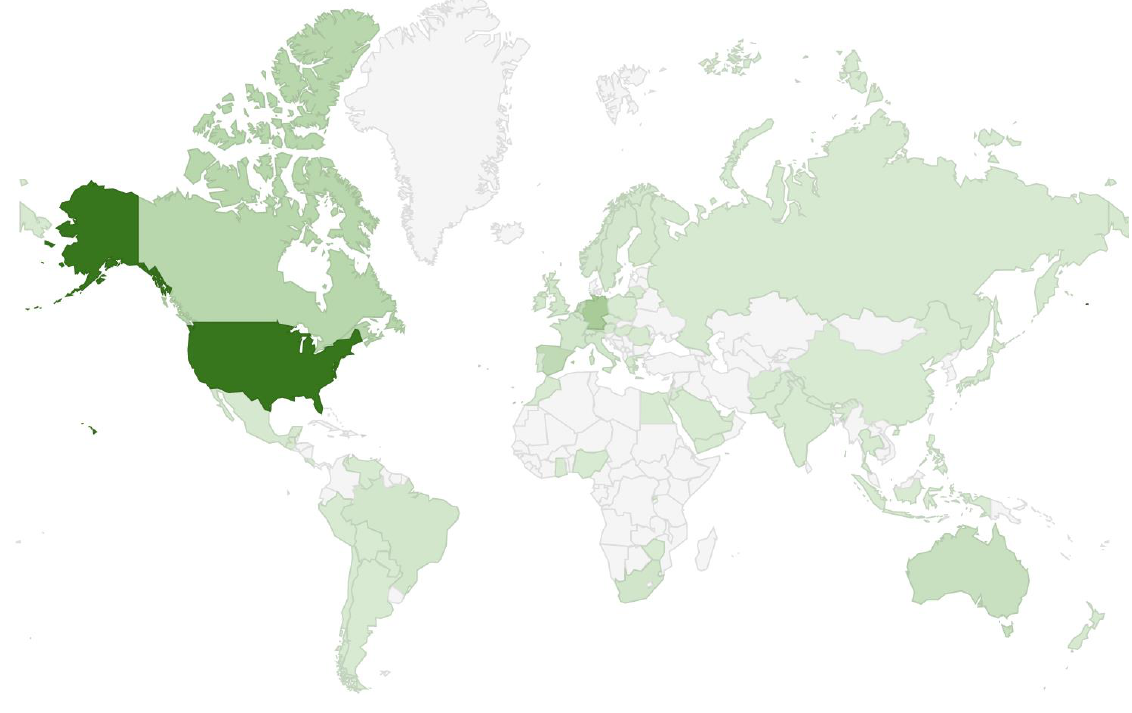
Figure 1. Target hashtag tweets by country.